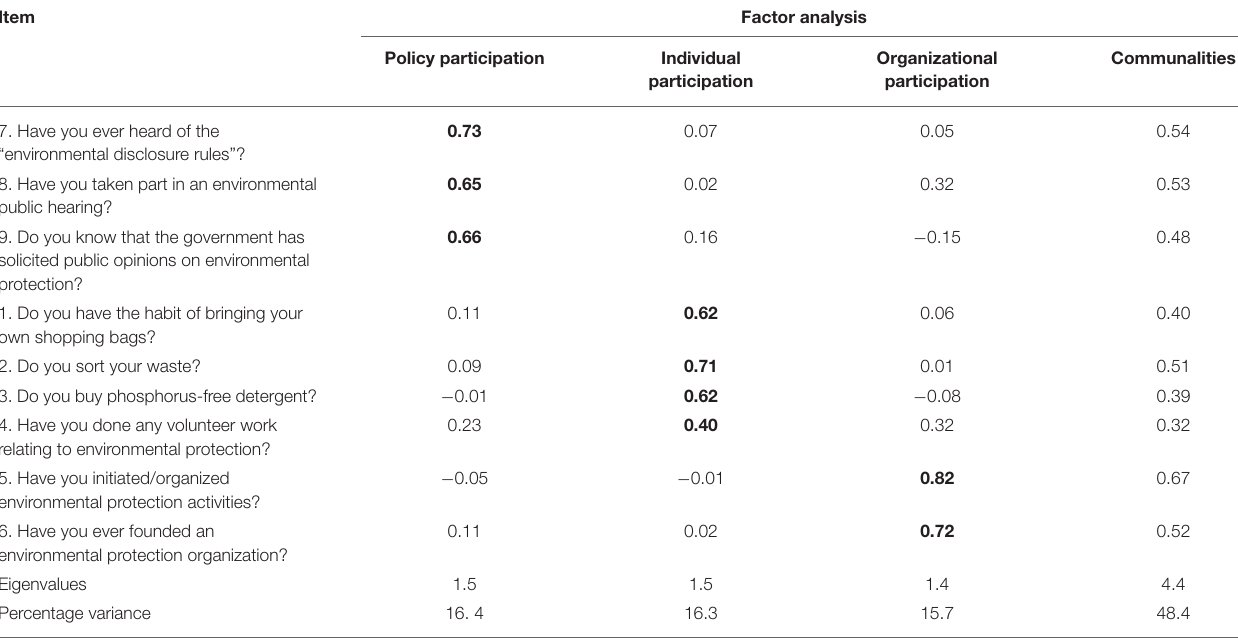
TABLE 4 | Factor analysis of environmental behaviors.